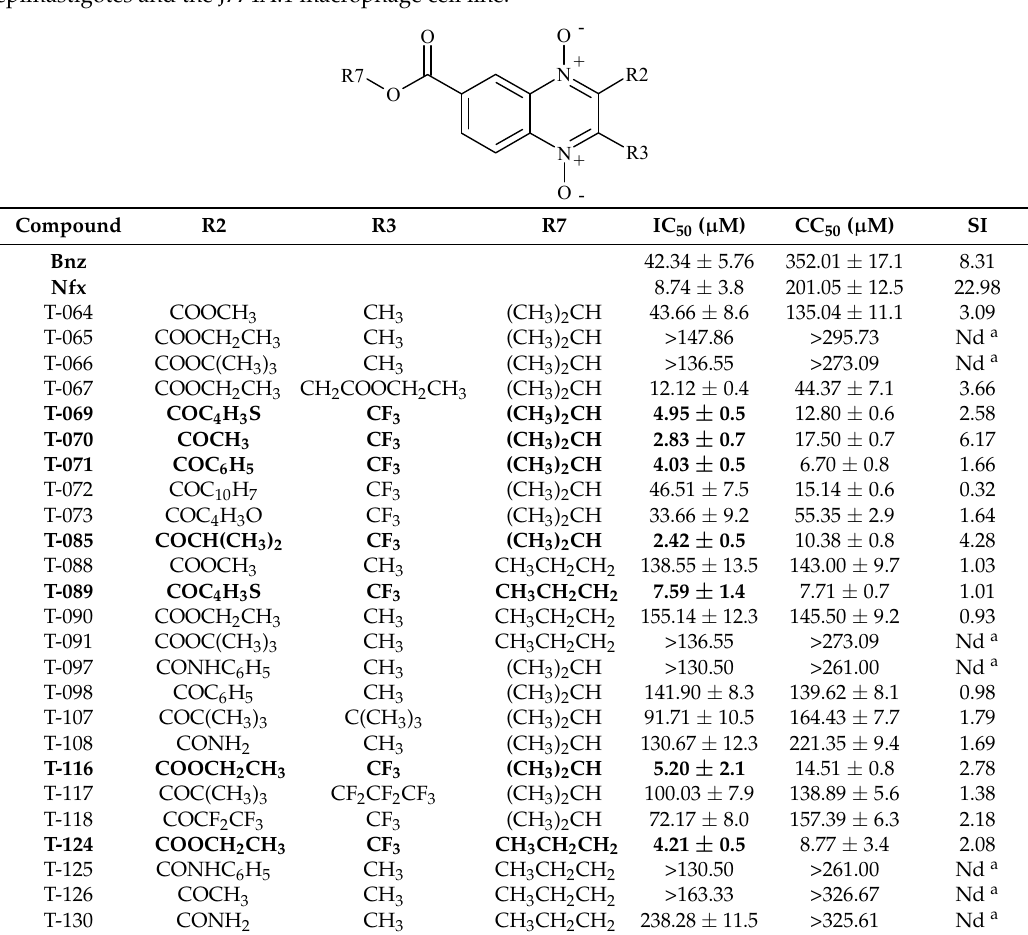
Table 1. Structure and in vitro biological activities of quinoxaline 1,4-di- N -oxide on T. cruzi INC-5 epimastigotes and the J774A.1 macrophage cell line.